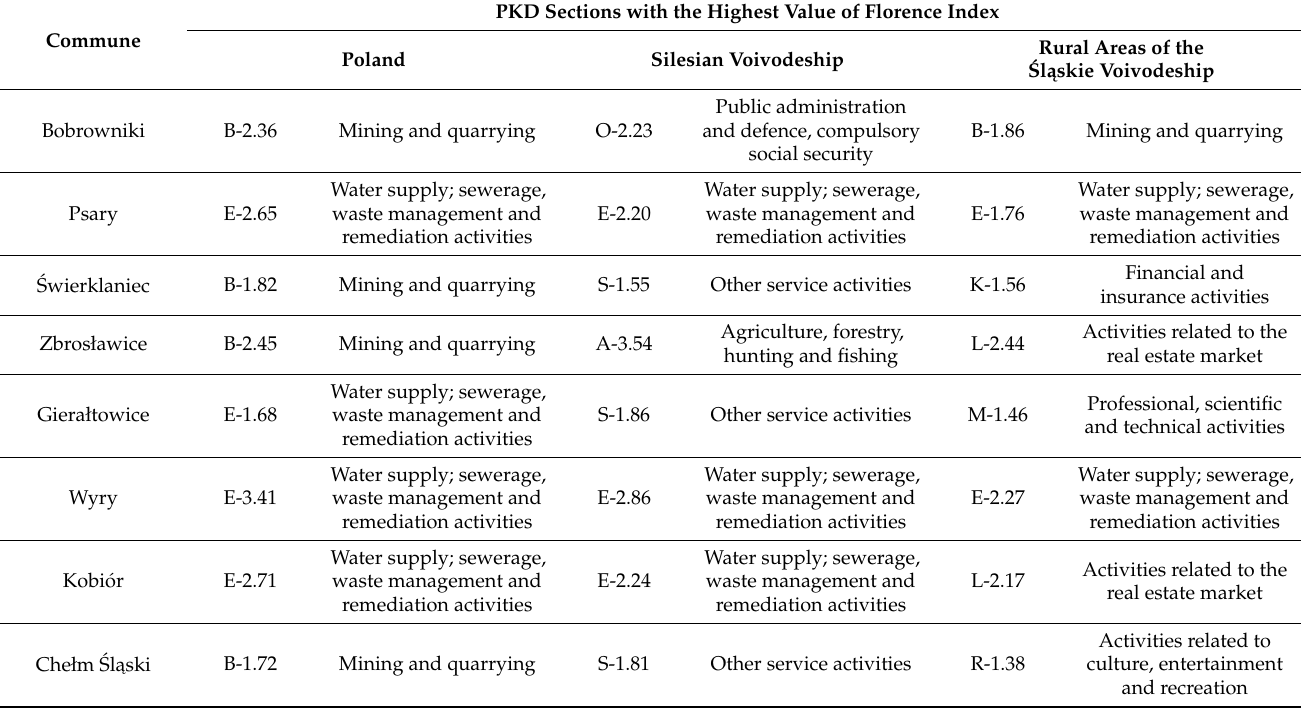
Table 6. P.S. Florence’s local specialization index of the researched rural communes by economic entities in 2016. Commune